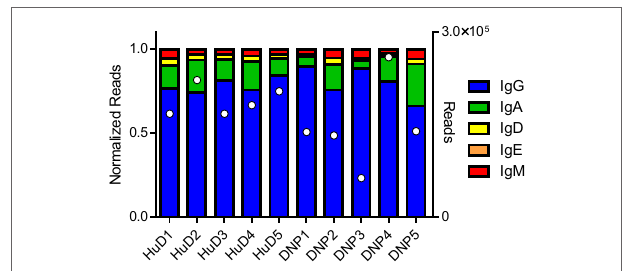
FigUre 1 | The NGS dataset included a small section of the constant domain that allows identification of the class of immunoglobulin. The reads were normalized, but the total number of processed reads included for each sample has also been plotted in white markers on the right axis. In all samples, the majority of reads belonged to the IgG class, followed by IgA and the other classes. Differences were observed between subjects but no relation to the treatment could be shown.